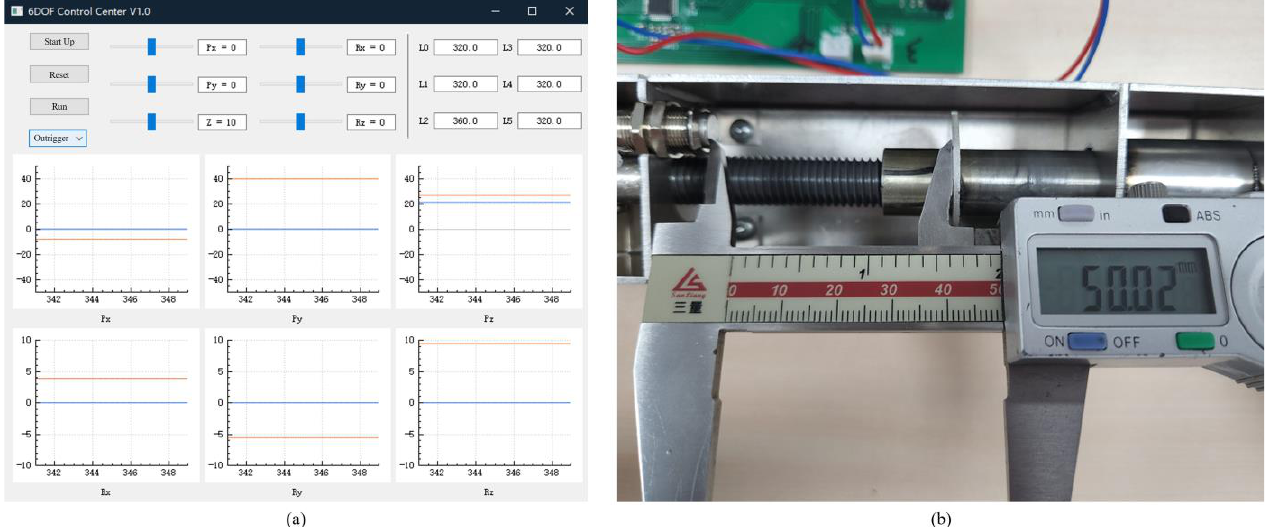
Figure 23. Closed-loop control of the arm length; ( a ) L2 set movement 50 mm; ( b ) L2 measured movement 50.02 mm.